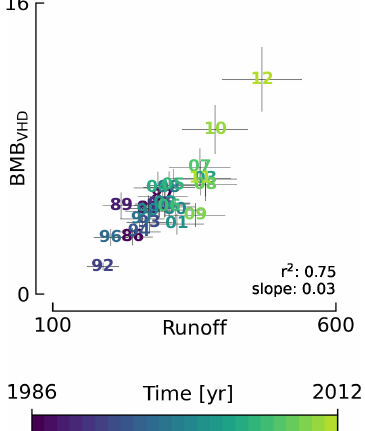
Figure D1. Comparison between MAR runoff and basal viscous heat dissipation derived from that runoff. The slope is used to es- timate the reconstructed BMB VHD from reconstructed runoff (see Sect. 5.3). Axis units are Gtyr − 1 . Plotted numbers represent the last two digits of the year.